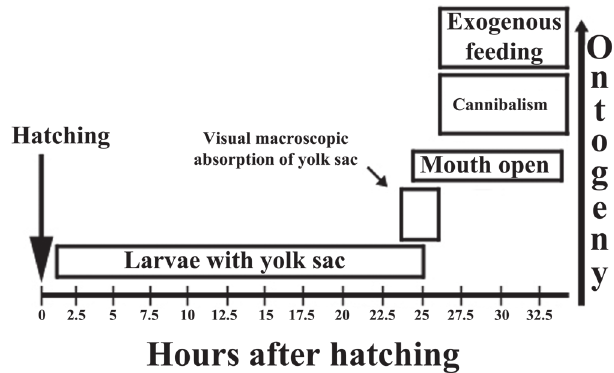
Fig. 3. Major events during the ontogeny of Salminus hilarii